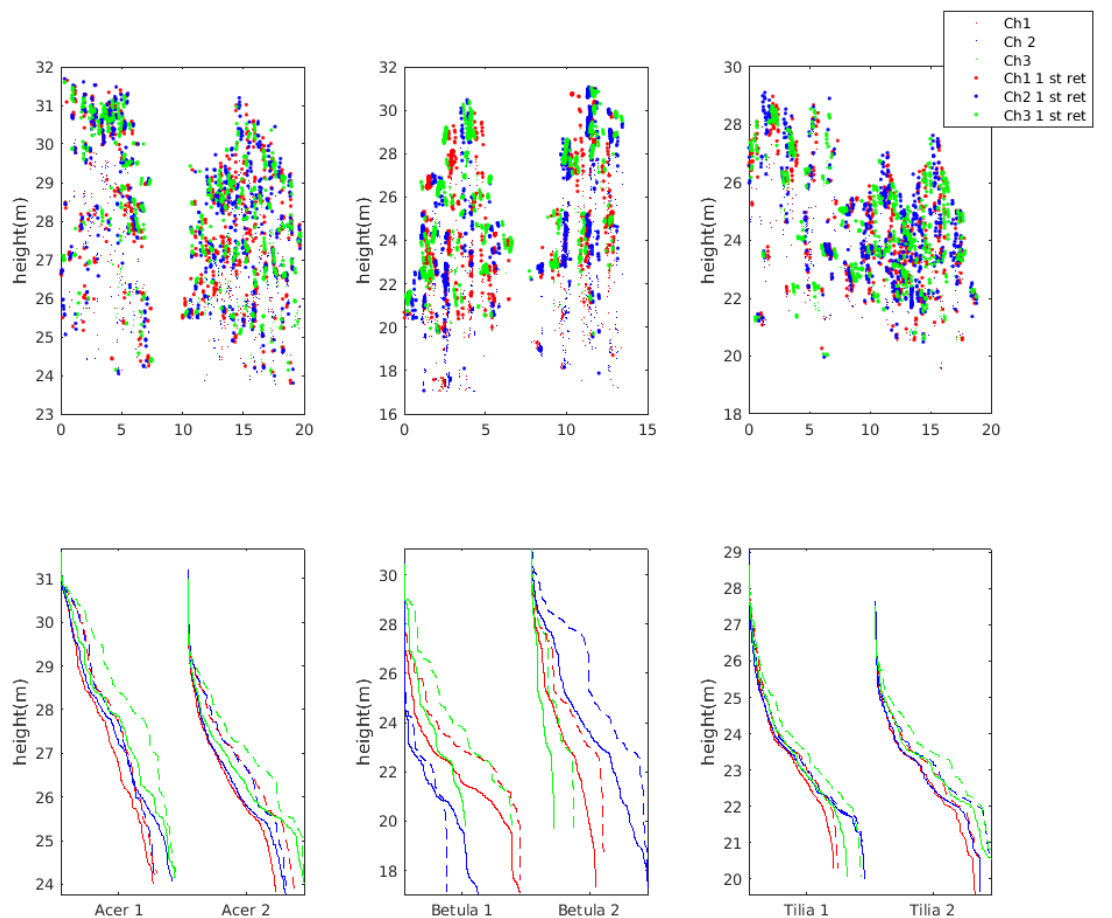
Figure 10. Side view and cumulative height distribution of pulses reflecting from deciduous trees, Acer platanoides, Betula pendula, and Tilia x vulgaris in three channels. Channel 1 is indicated in red colour, channel 2 in blue, and channel 3 in green, correspondingly. Little dots are intermediate or last pulses and bigger dots are first or only pulses. Side view of trees (upper row) and cumulative height distribution (lower row). 1 st pulse data are in dashed lines. Intermediate and last pulses are in solid